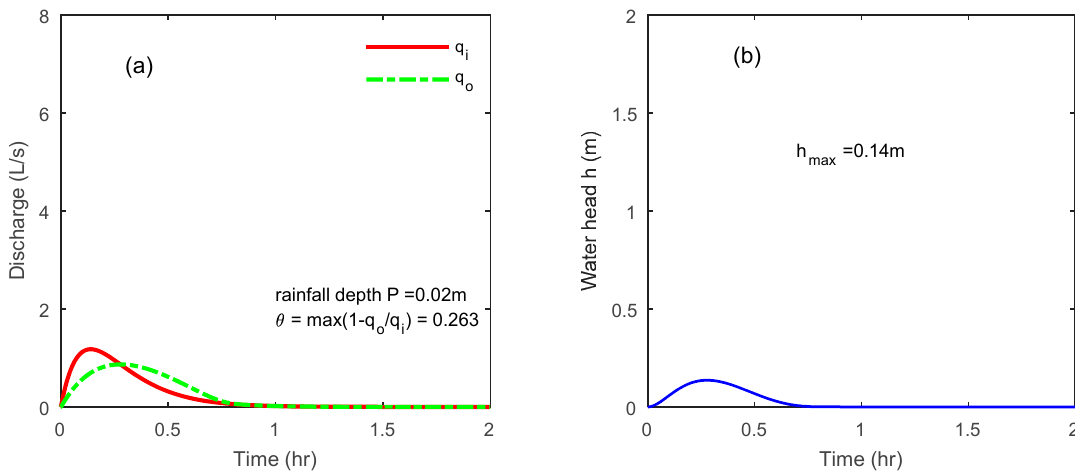
Figure 7. Discharge and water head of the buffer tank during small rain. ( a ) Discharge flow; ( b ) water head in the tank.